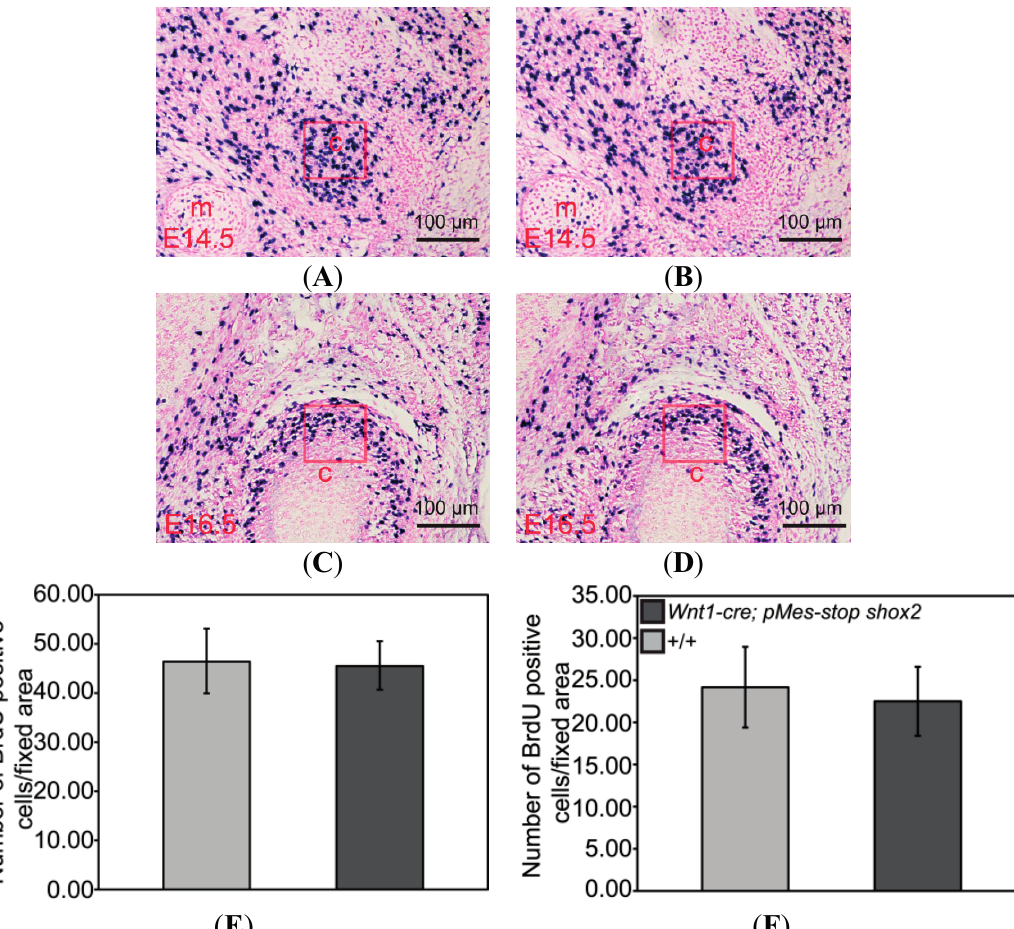
Figure 6. Changes of proliferation in the TMJ of Wnt1-Cre ; pMes-stop Shox2 mice. ( A – D ) BrdU labeling of cell proliferation in the condylar condensation of an E14.5 ( A , B ) and E16.5 ( C , D ) in wild type and Wnt1-Cre ; pMes-stop Shox2 embryo; ( E , F ) Comparison of numbers of BrdU positive cells in the fixed area (red frame) of the condylar primoridain between wild type ( E ) and Wnt1-Cre ; pMes-stop Shox2 embryos ( F ). Standard deviation is shown as error bars. c, condyle; and m, Meckel’s